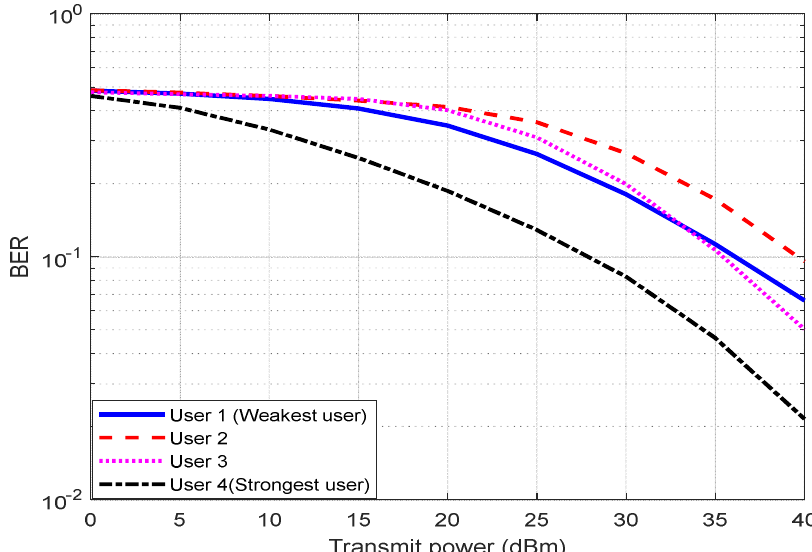
Figure 4. BER against transmitting power for four users with varying distances and power coefficients, for DL NOMA at BW (200 MHz).